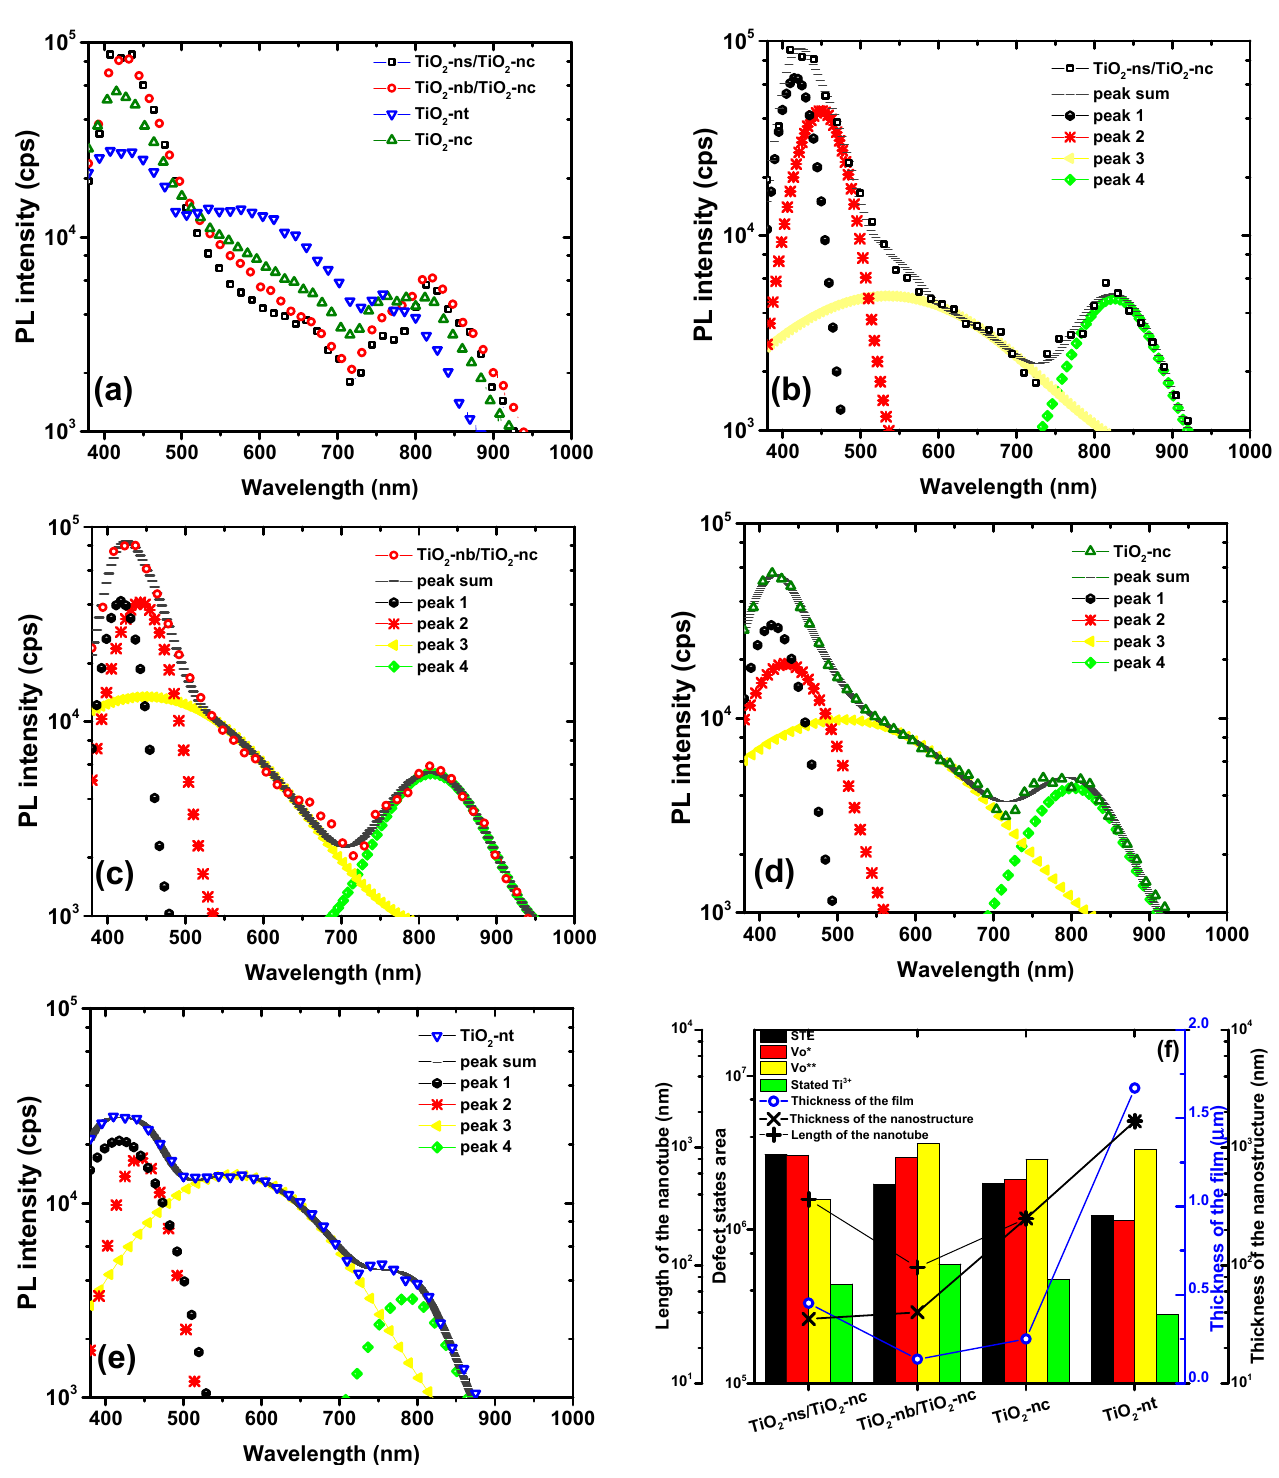
Figure 4. ( a ) Photoluminescence spectra of the four TiO 2 nanostructures. Deconvolution of the pho- toluminescence spectra for: ( b ) TiO 2 -ns/TiO 2 -nc; ( c ) TiO 2 -nb/TiO 2 -nc; ( d ) TiO 2 -nc; and ( e ) TiO 2 -nt. ( f ) Comparison of defect states, length of nanotube, thickness of the film and of the nanostructure be- tween the four nanomaterials.